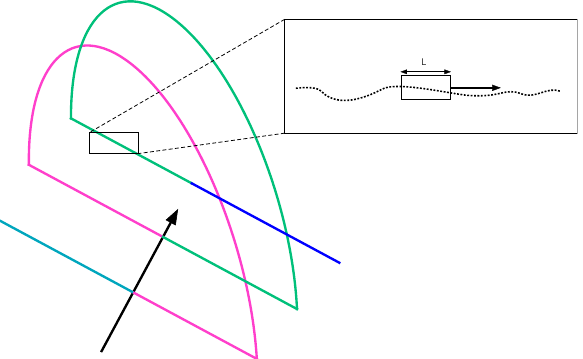
Figure 3. Scanning pattern of the profile. Each new colour represents a new profile number. The driving direction is marked with an arrow. The zoomed in section gives how the sliding window algorithm is used.